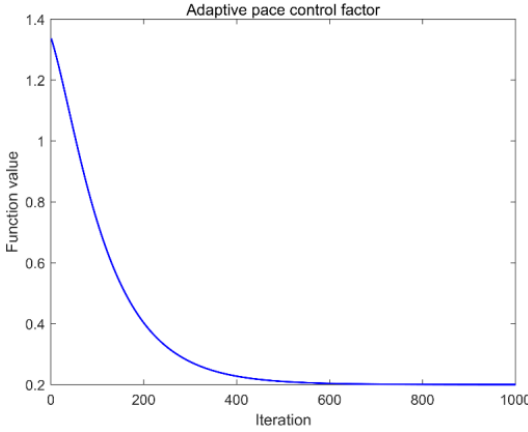
Figure 2. The plot of the adaptive step control factor.